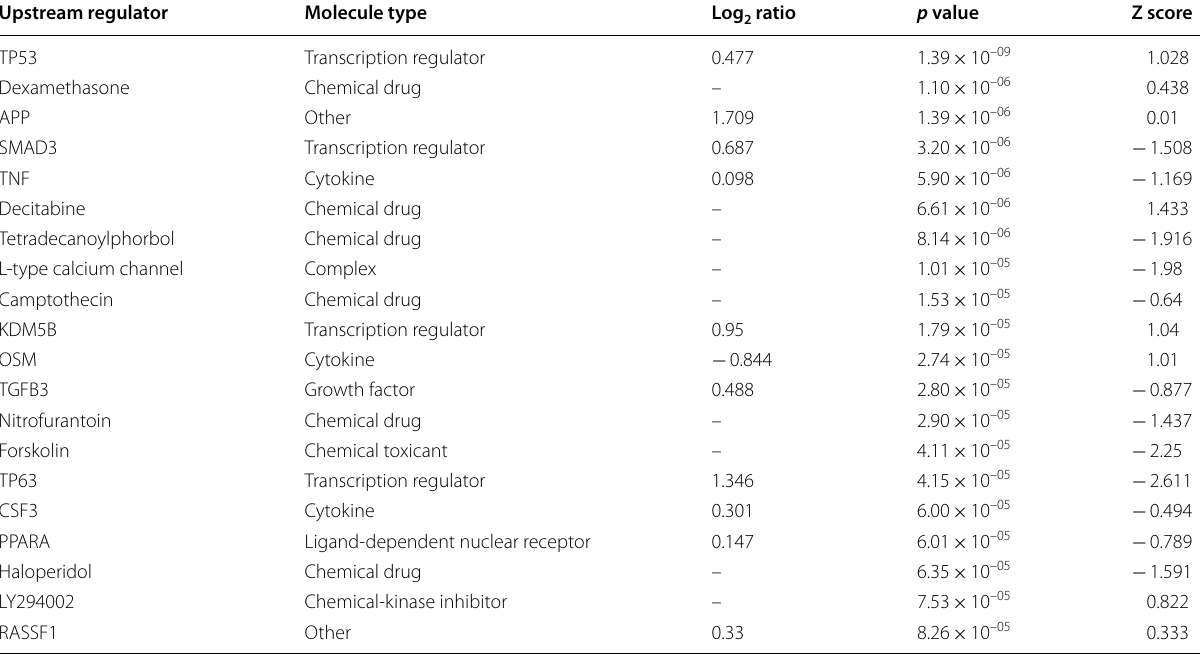
Table 3 Top 20 upstream regulators revealed by Ingenuity Pathway Analysis Upstream